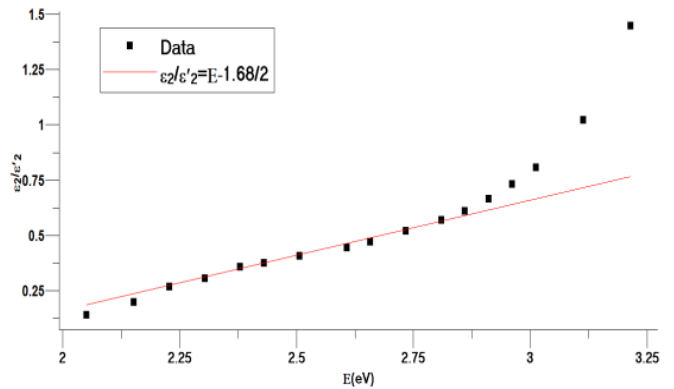
Fig. 3: ⁄ data for a-Si:H films.